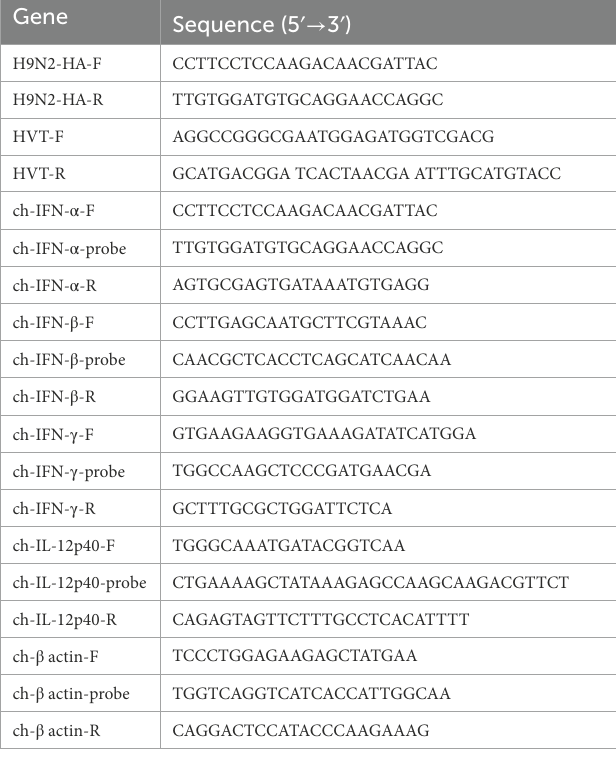
TABLE 1 Primes and probes for PCR or real-time PCR.